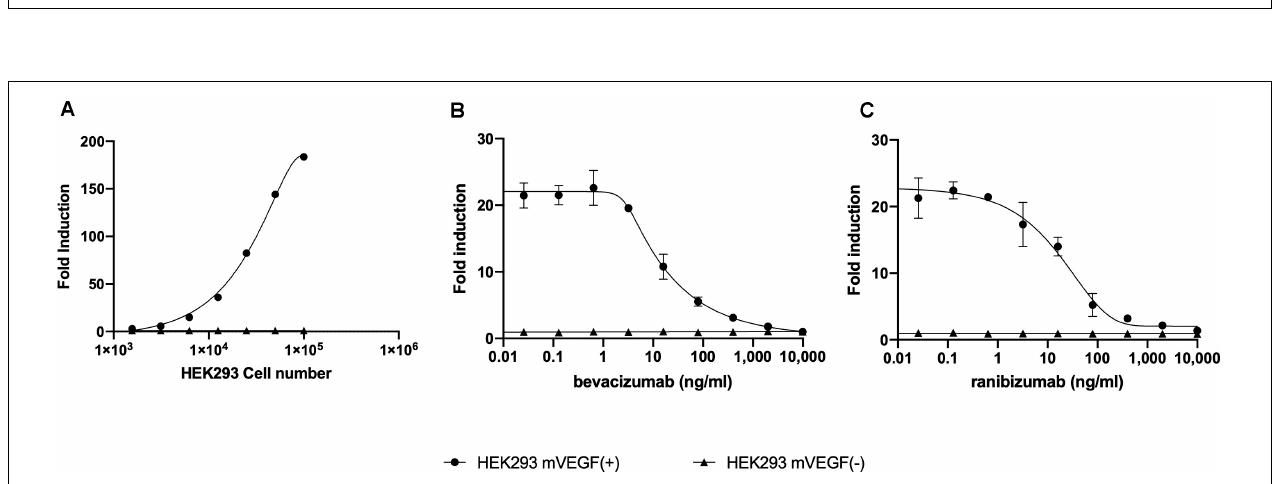
FIGURE 1 | The VEGF responsive reporter-gene cell line was incubated for 18 h with increasing concentrations of VEGFA either alone or in the presence of 1.0% normal human serum prior to quantification of FL activity as described in the section “Materials and Methods” (A) . Increasing concentrations of bevacizumab were mixed with 25 ng/ml of VEGFA for 30 min at room temperature prior to incubation for 18 h with VEGF responsive reporter-gene cells either alone or in the presence of 1.0% normal human serum and quantification of FL activity as described in the section “Materials and Methods” (B) . The associated Table to the Figure shows the principal parameters of a 4PL plot determined using the Prism software.